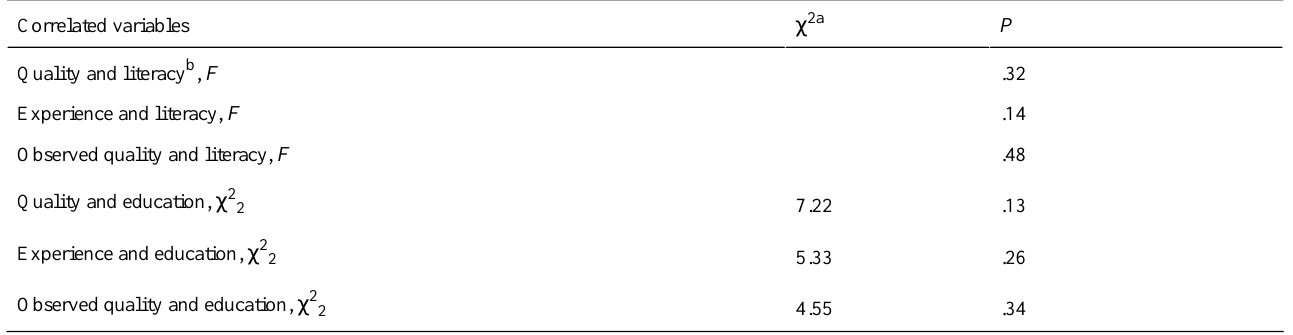
Table 10. Correlations between quality and experience of care and ASHA characteristics.